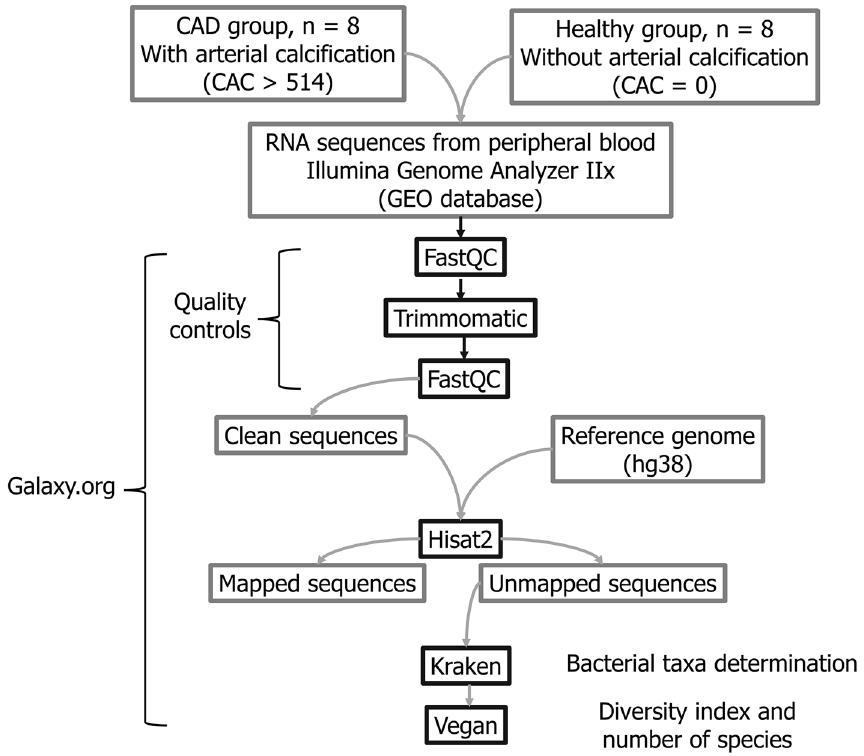
Figure 1. Workflow of data analysis. RNA sequences were mapped to the GRCh38 human reference genome and unmapped reads were fed into Kraken to classify the reads to bacterial taxa. The richness and diversity indices were obtained using Vegan.